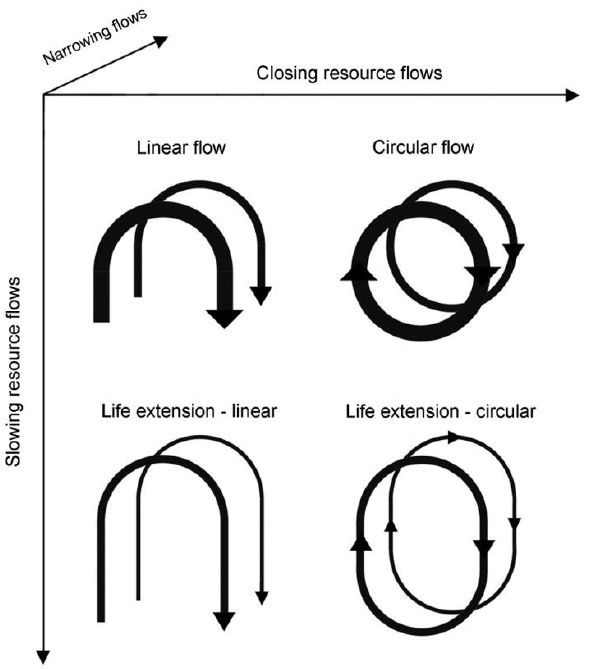
Figure 2. Categorization of linear and circular approaches for reducing resource use. From Nancy et al. [12].